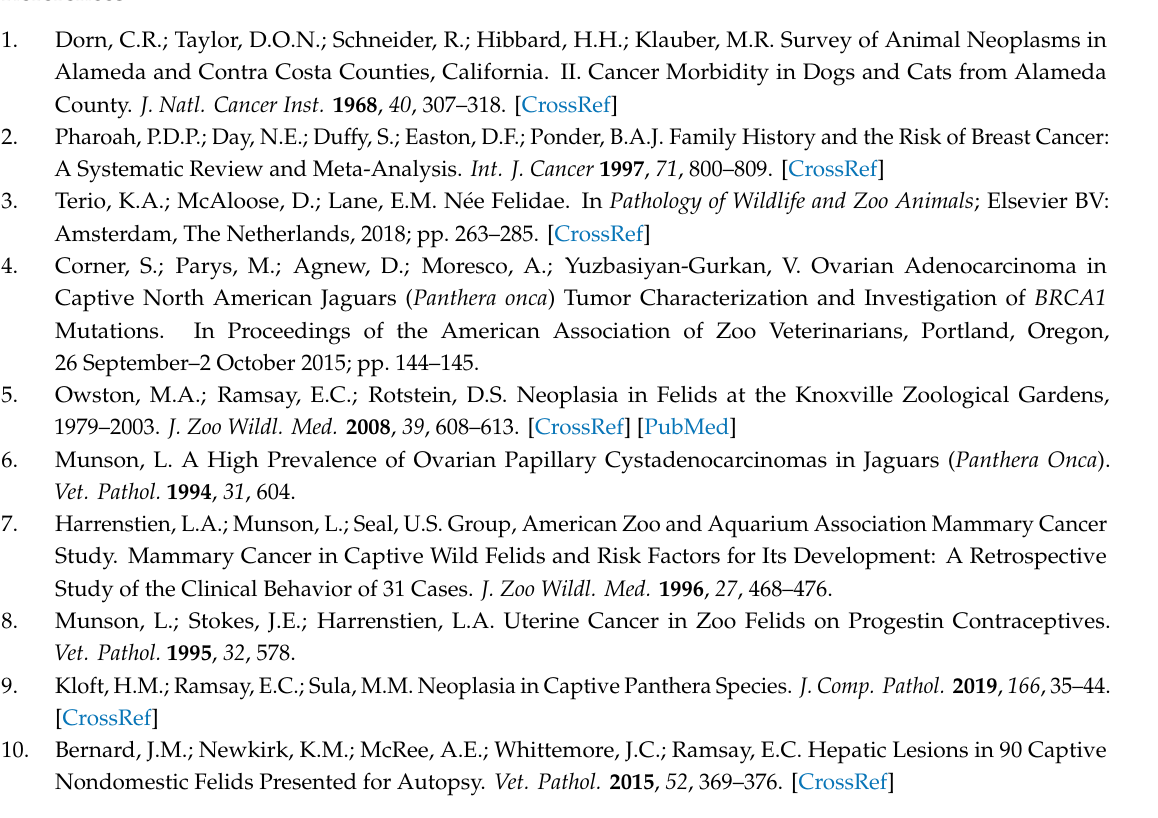
s1. Table S1: Histopathology classification scheme; Table S2: Primary neoplasia cases in felids across the